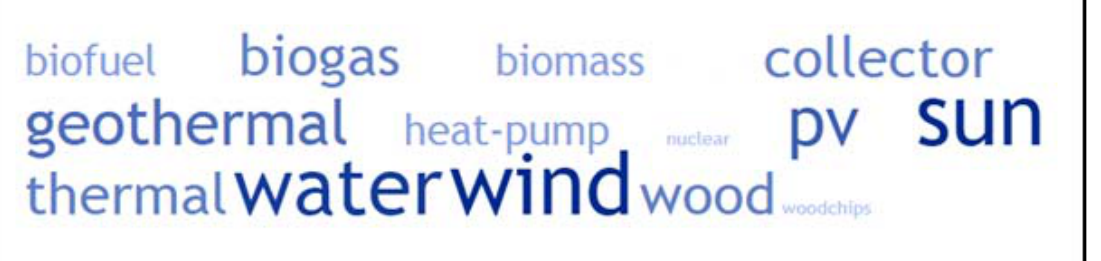
Figure 7. Associations of local prominence on renewable energy sources (authors’ edition).